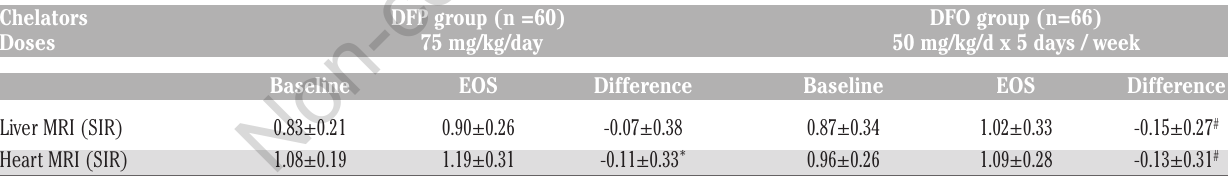
Table 5. Changes in liver iron and cardiac iron content with standard doses of DFP vs DFO (Data from Maggio A, et al. Blood Cells, Molecules, and Diseases 2002; 196–208). Chelators